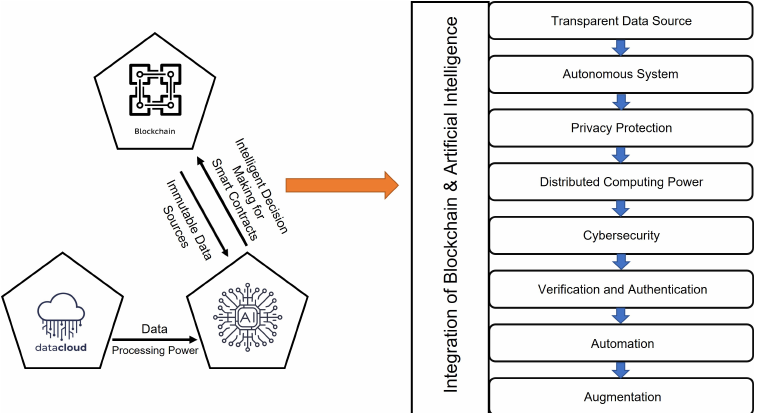
Figure 1. The interaction of emerging technologies including AI, blockchain, and